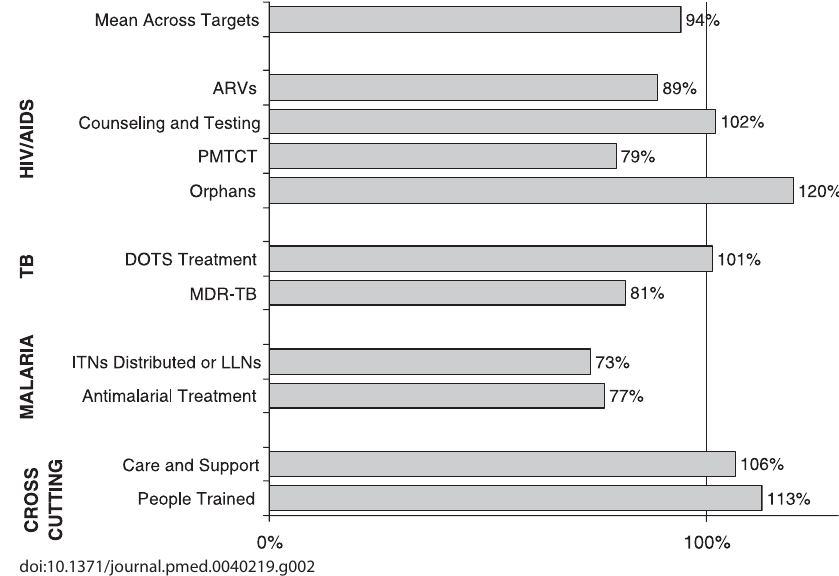
Figure 2. Variability in Programmatic Performance in Major Service Areas for HIV/AIDS, TB, Malaria, and Cross-Cutting Care, Support, and Training ARV, antiretroviral; DOTS, directly observed treatment, short-course; LLN, long-lasting net; MDR-TB, multidrug-resistant tuberculosis; PMTCT, prevention of mother-to-child